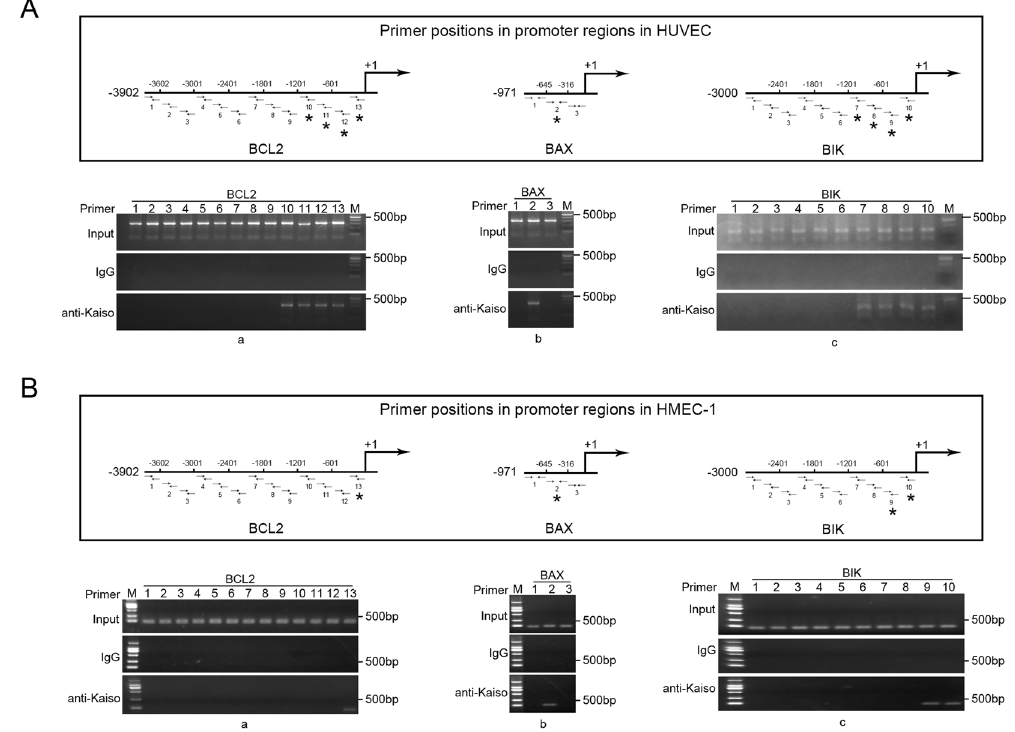
Figure 5. Kaiso binds to the promoters of BCL2, BAX, and BIK. DNA fragments (200–500 bp) were obtained from nuclear lysates of HUVECs ( A ) and HMEC-1s ( B ), respectively, and were subjected to chromatin immunoprecipitation. Mouse monoclonal anti-Kaiso 6F/6F8-CHIP grade antibody was used for Kaiso/DNA complex precipitation and the precipitated DNA fragments were amplified using primers targeting promoter regions of BCL2 ( − 3902 to − 1 bp) ( A ,a and B ,a), BAX ( − 971 to − 1 bp) ( A ,b and B ,b) and BIK ( − 3000 to − 1 bp) ( A ,c and B ,c). Primer positions (horizontal arrows) are shown in the schematic drawings in the upper panel in A and B. Asterisks mark the positively amplified promoter regions. Normal mouse IgG was used as a negative control. M: DNA marker. ( A ) In HUVECs, Kaiso binds to the promoter regions − 1201 to − 1 bp of BCL2, − 645 to − 316 bp of BAX and − 1201 to − 1 bp of BIK (Asterisks). ( B ) In HMEC-1s, Kaiso binds to the promoter regions − 301 to − 1 bp of BCL2, − 645 to − 316 bp of BAX and − 601 to − 1 bp of BIK (Asterisks). Detailed primer positions and sequences were listed in Supplementary Table